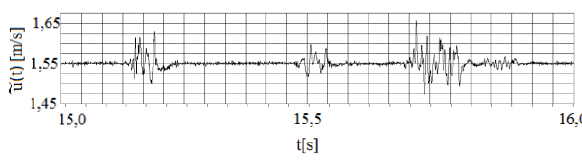
Fig. 3. Filtred signal u (t ) of fluctuations of instantneous velocity, [3]